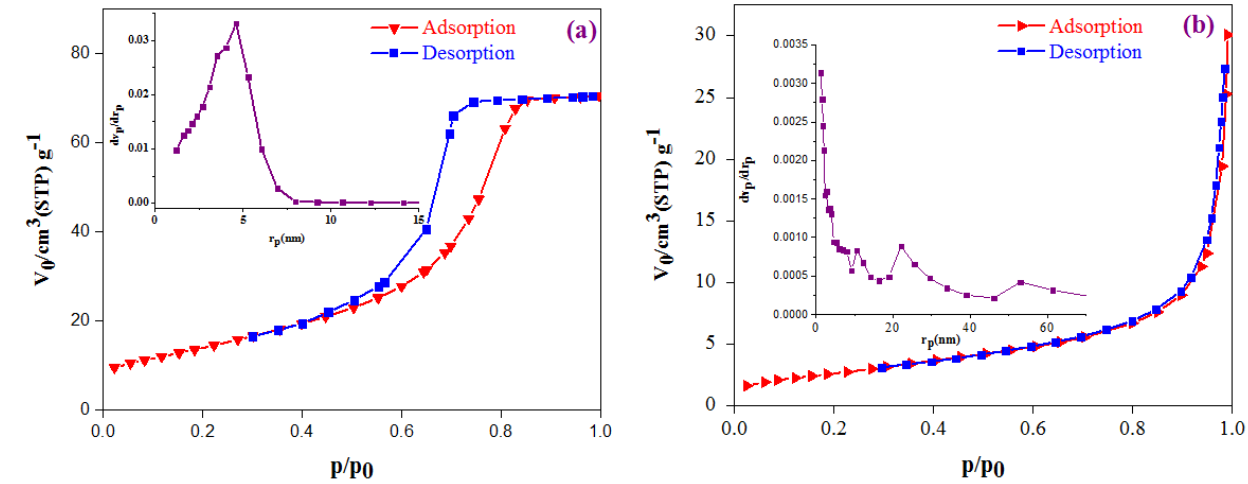
Figure 3. BET analysis of TiO 2 ( a ) and Cu-TiO 2 ( b ) and the BJH plots (inset). The optical properties of pure TiO 2 and Cu-TiO 2 products were measured using the UV-Vis DRS analyses, and the results are given in Figure 4. Based on Figure 4a, the role of Cu doping on the spectra profile of Cu-TiO 2 is visible by shifting the absorption edge of TiO